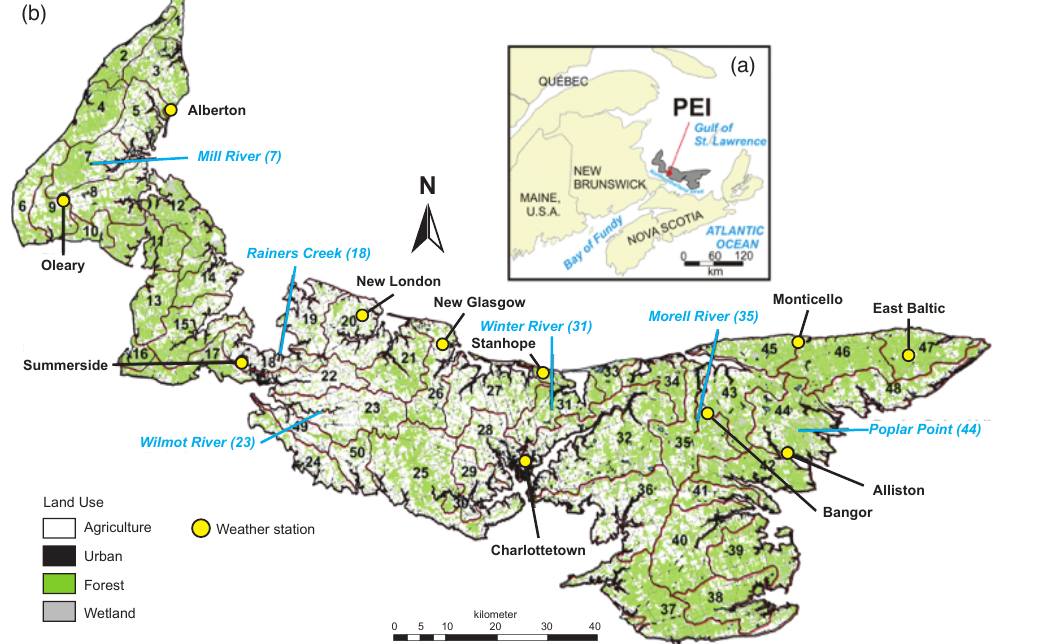
Figure 1. (a) Location of Prince Edward Island (PEI) in eastern Canada. (b) Limits of the watersheds (numbered area delineated with brown lines, see names Table S1), with identification of the major rivers (names in blue), along with land use (see legend) and location of the weather stations (names in black).